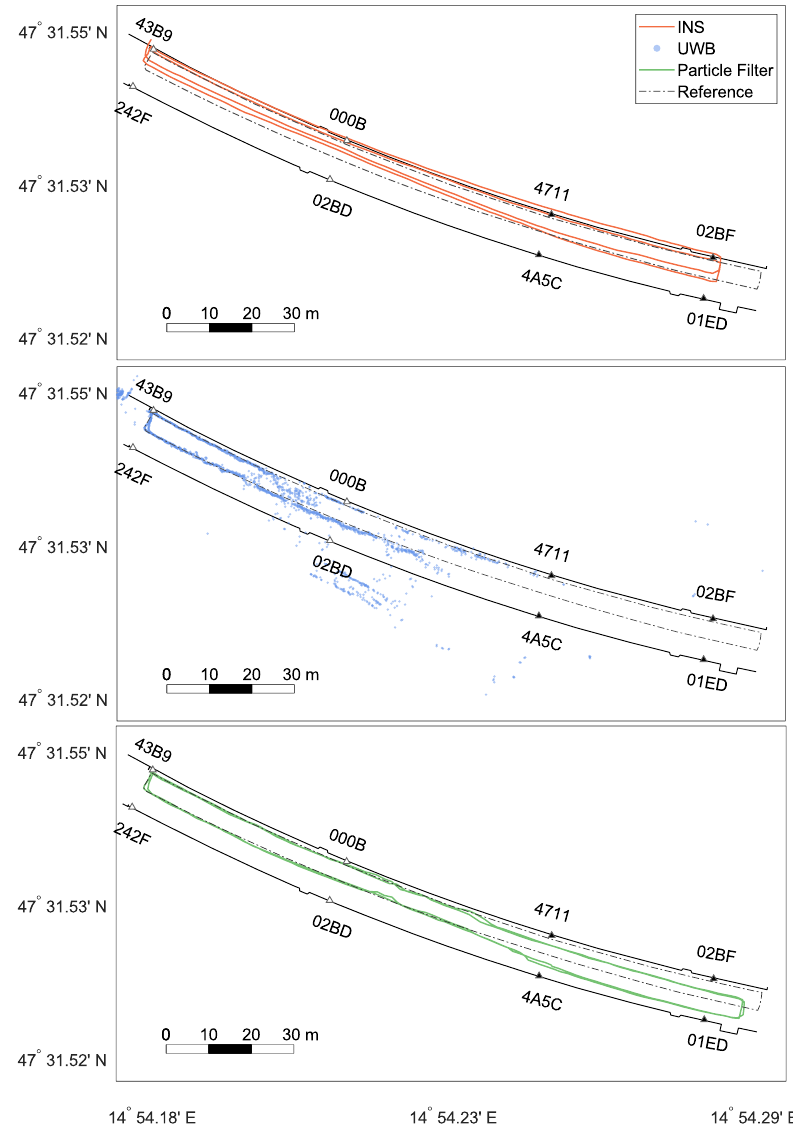
Figure 12. Filter solutions of Test 5. The top panel, middle panel, and bottom panel show the accumulated position changes from the INS, the derived position from the ultra-wideband (UWB), data and the filter solution, respectively. The UWB anchors are marked as triangles (white filling: on, black filling: